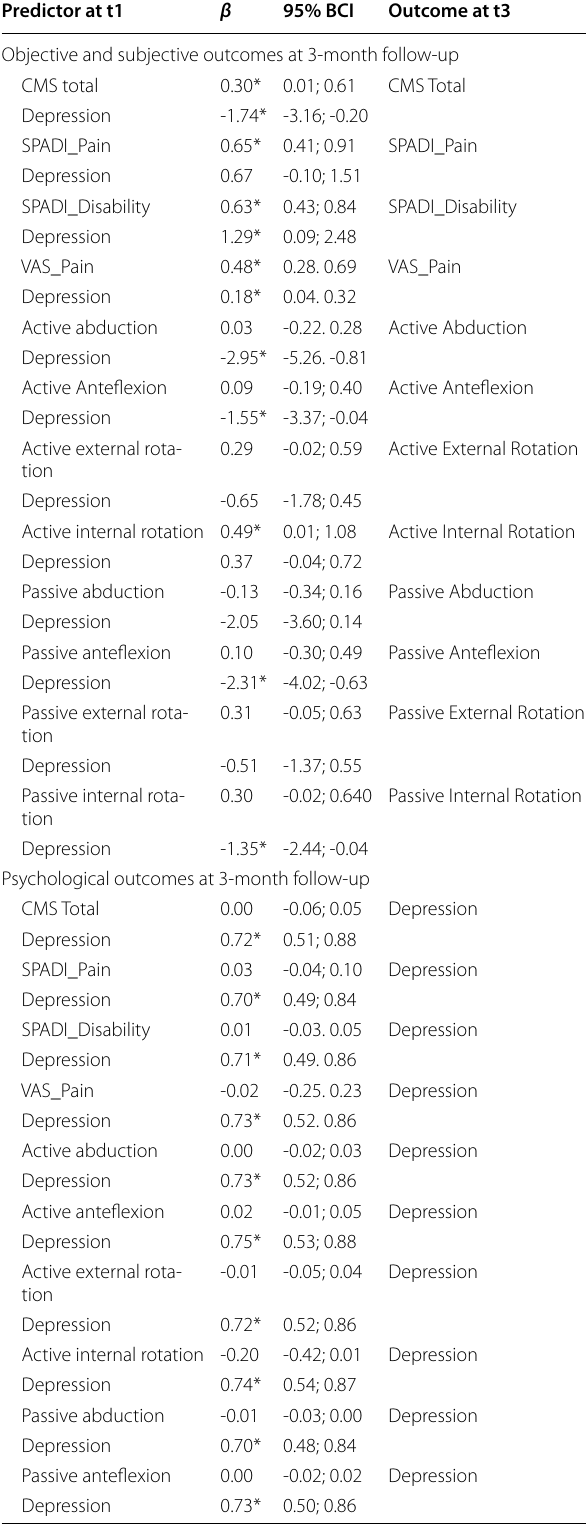
Table 3 The reciprocal effects between objective and subjective outcomes of hydrodilatation and depression Predictor at t1 Objective and subjective outcomes at 3-month